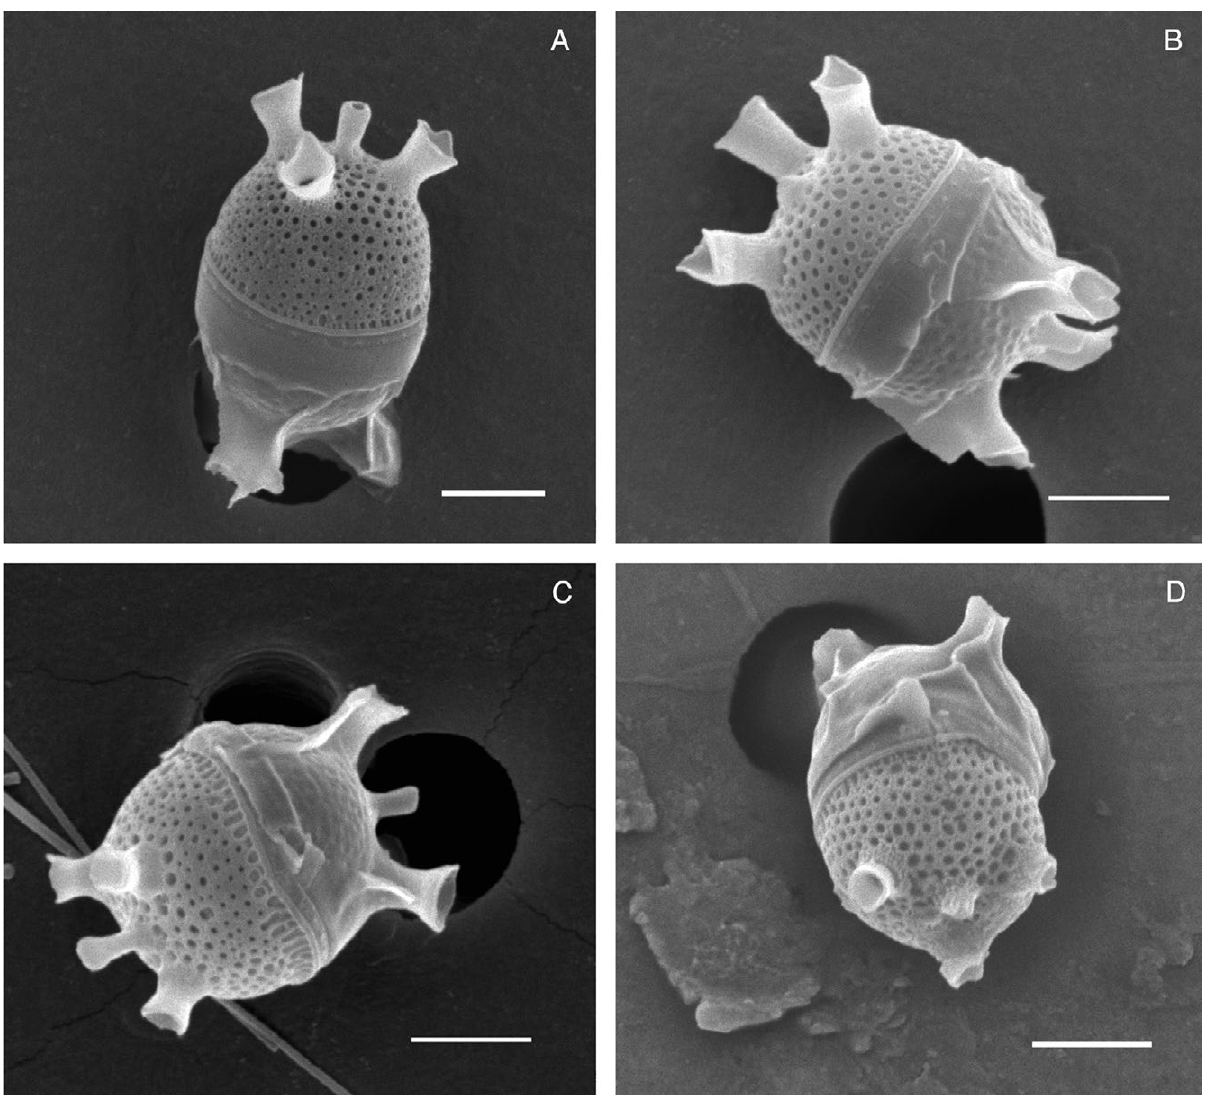
Fig. 4. – Small diameter cells of Minidiscus comicus showing the increased doming of the mantle to form spherical cells (A-C) and even oblong cells (D). A-C, 11 May 2009; D, 21 March 2009. Scale bar 1